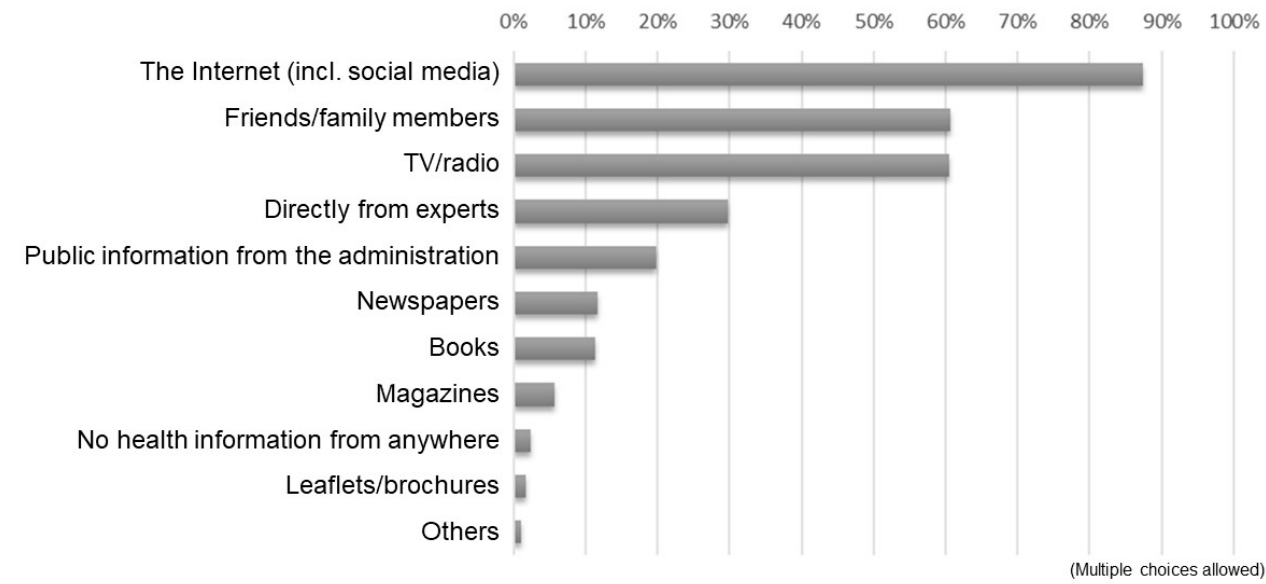
Figure 1. Responses to the question, “Which information source do you use when obtaining health information?”.